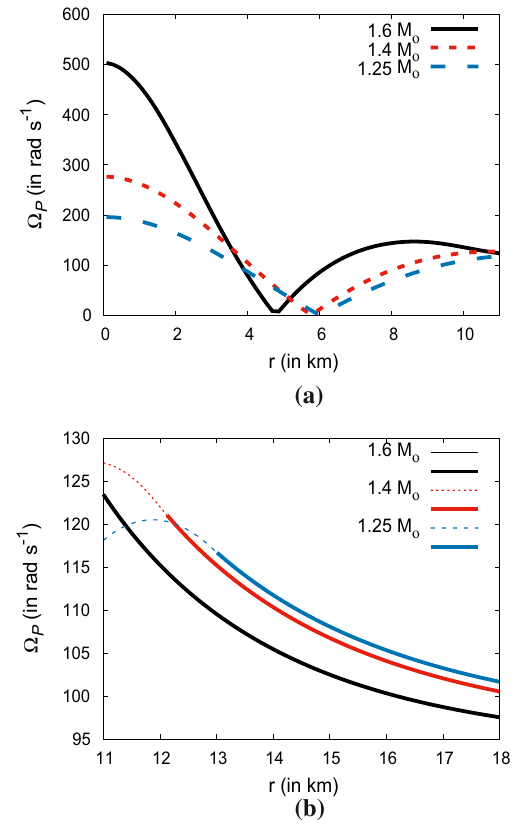
Fig. 16 a Ω P of the gyro orbiting with Ω = 100 rad s − 1 around NS ( ω = 700 rad s − 1 ) of different mass is shown in the figure. The black solid line shows variation of Ω P for a 1 . 6 M ◦ star, the red short dashed and blue dashed line are for 1 . 4 M ◦ and 1 . 25 M ◦ respectively. b Ω P of the gyro in the exterior region of the star. The nomenclature of curves are same as that of a